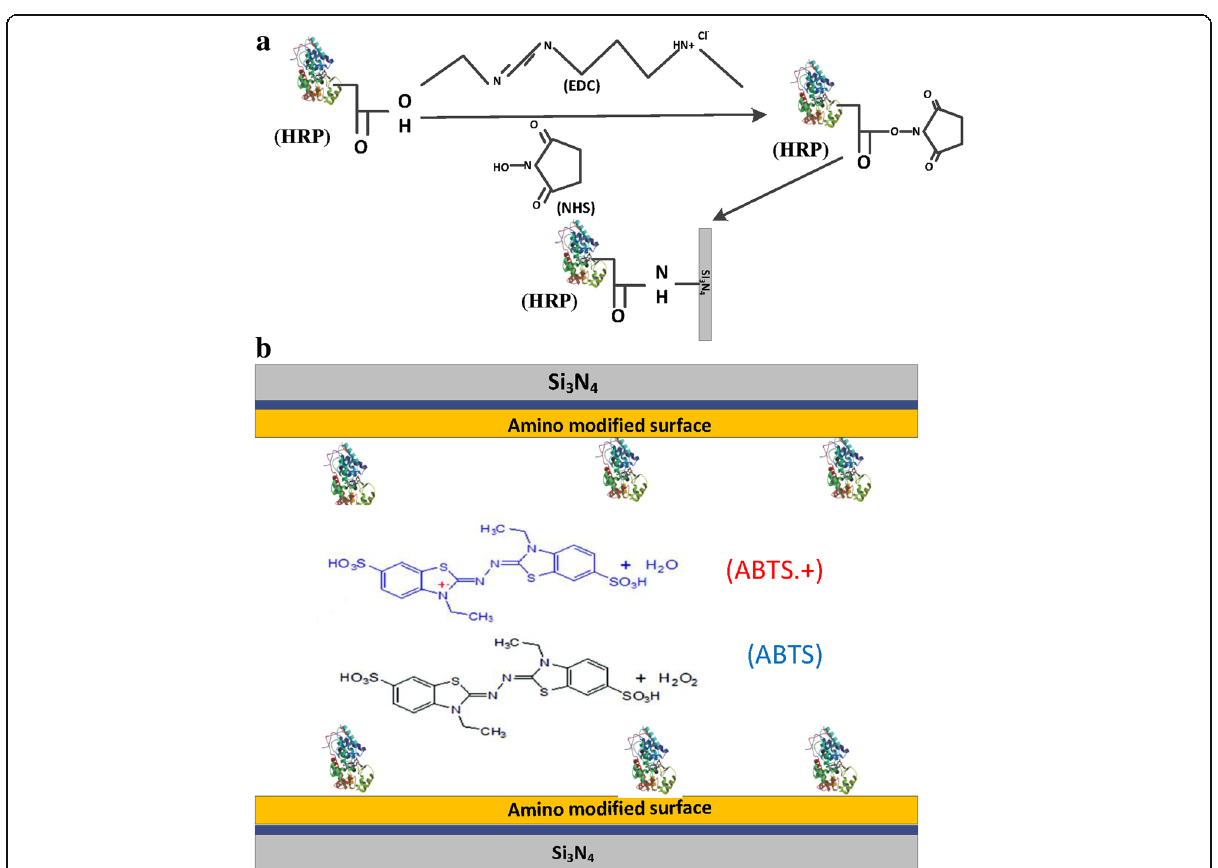
Fig. 1 Performing modification process in a single solid-state nanopore channel. a Schematic representation of the covalent attachment of horseradish peroxidase (HRP) to a single nanopore channel via carbodiimide coupling chemistry. The carboxyl (-COOH) groups of HRP was activated by EDC solution, enabling the HRP to react with (-NH 2 ) generated on the surface of a nanopore chip. b Scheme of the immobilized HRPs hydrogen peroxide sensor, the inner surface of sensor was modified with HRPs. When H 2 O 2 and ABTS occurred, the ABTS (cid:129) + produced. The crystal structure of HRP was used with the permission from author